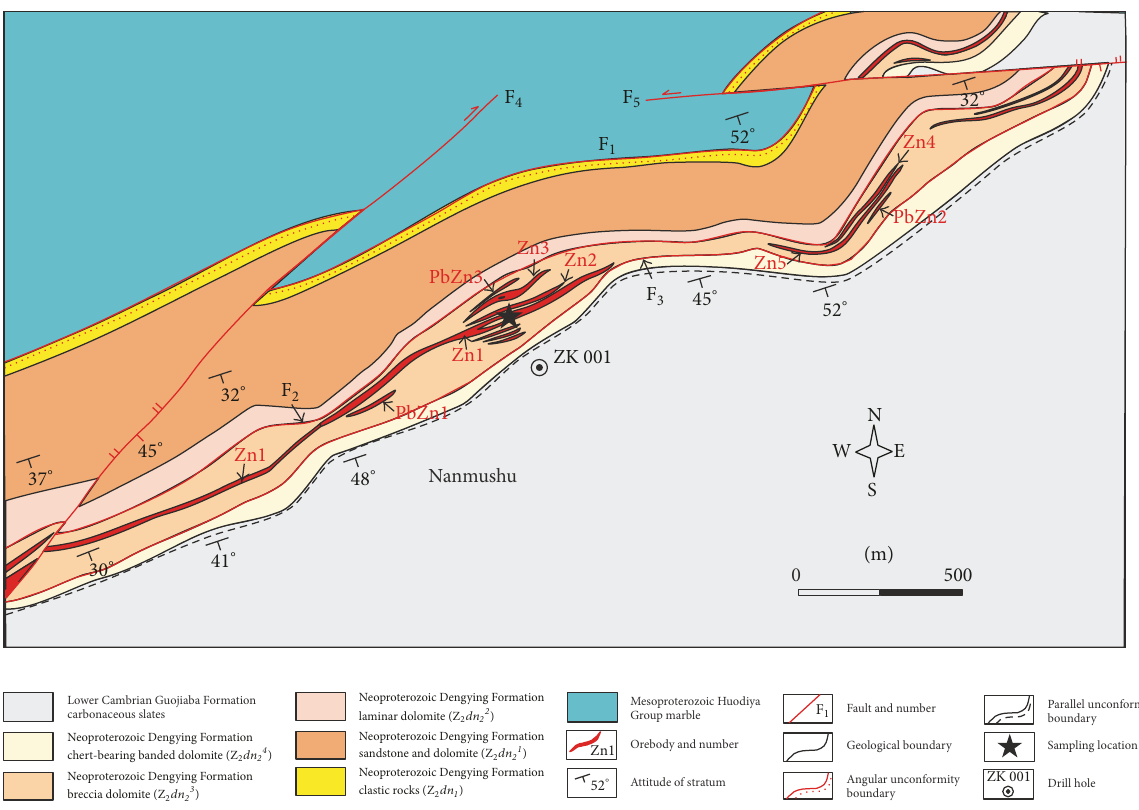
Figure 2: Geological map of the Nanmushu Zn-Pb deposit showing the orebodies are mainly hosted in the third section of Neoproterozoic Dengying Formation breccia dolomite (Z 2 𝑑𝑛 23 ) (after Han et al., 2016 [10]).